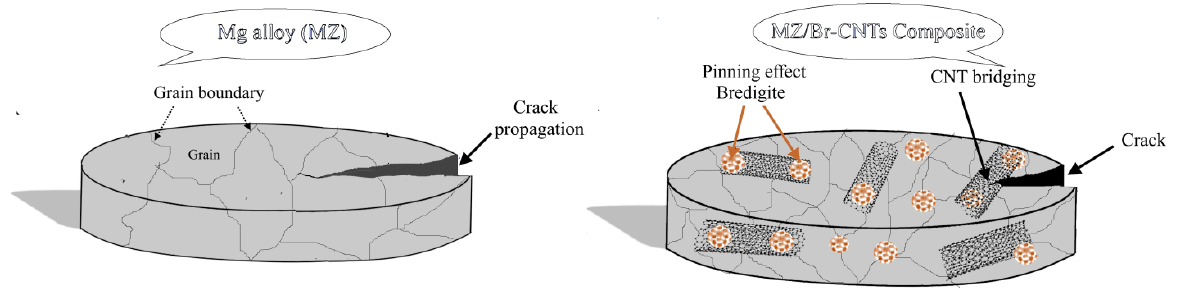
Figure 8. Schematic of the simultaneous strengthening mechanism of Br-CNTs during tension.